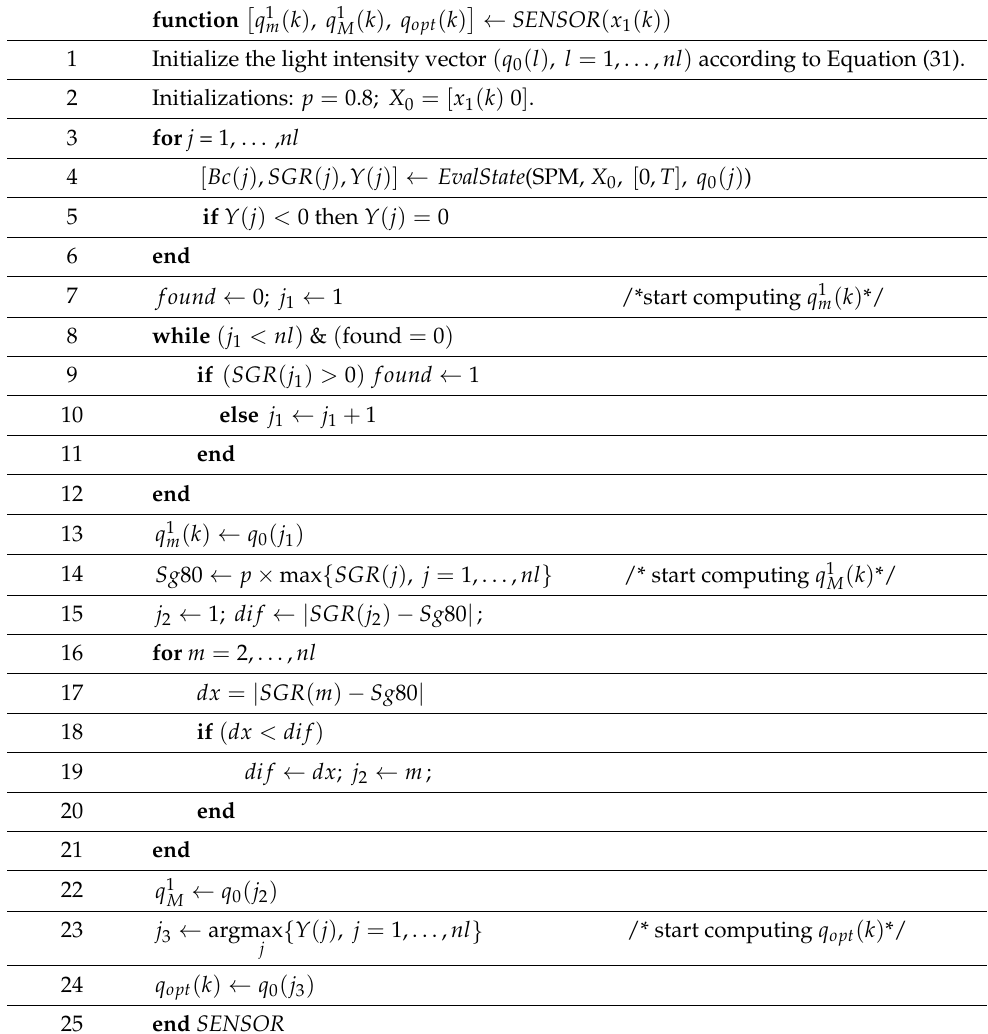
Table 2. Algorithm of the soft